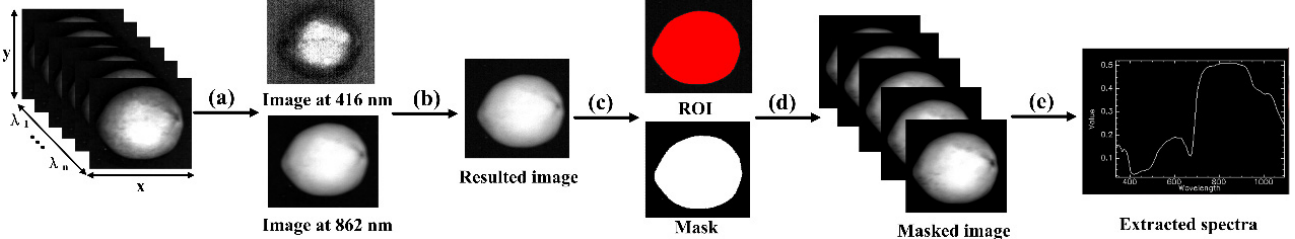
Figure 3. The main steps involved in the segmentation of hyperspectral images. ( a ) Selecting 416 nm and 862 nm images; ( b ) band math; ( c ) binarization; ( d ) applying the mask; ( e ) extracting the spectra of a Camellia oleifera fruit